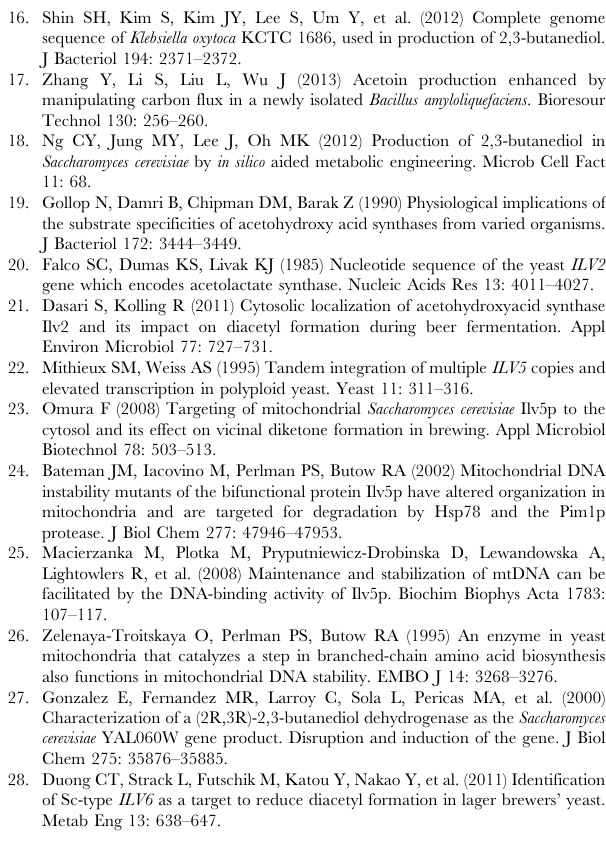
Table S1 The reactions with thiamine or NA as cofactor in the central metabolic pathway of C. glabrata . Table S2 Comparison of diacetyl production of strain DA-3 under different dissolved oxygen concentration. Table S3 Primers used in this